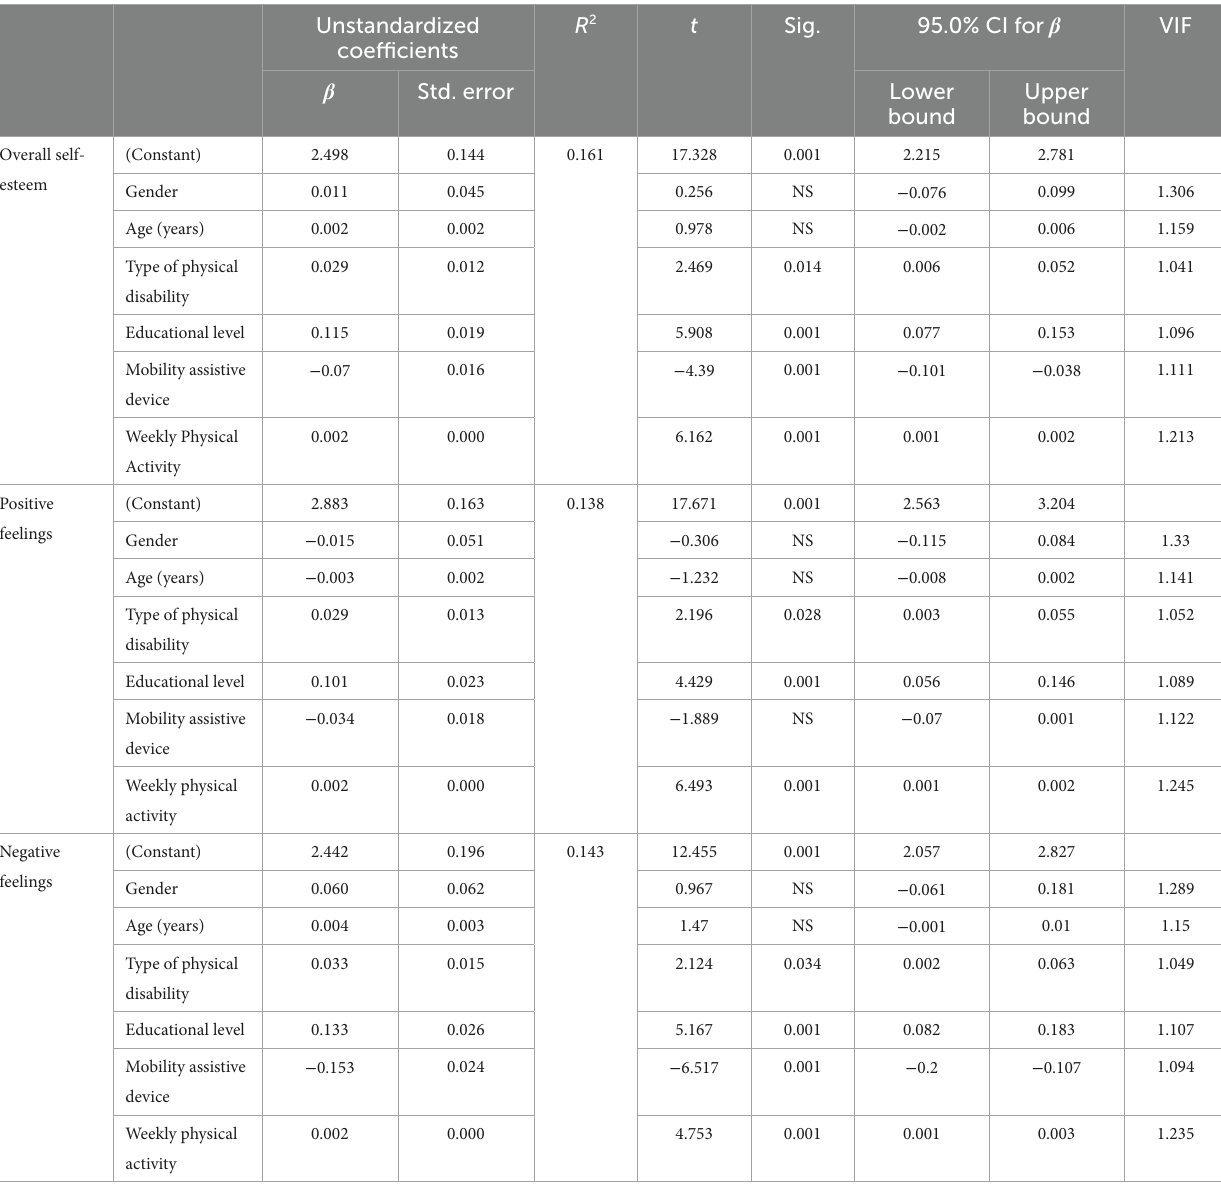
TABLE 2 Weighted least squares regression models for the effect of sociodemographic factors and weekly physical activity on the levels of overall self- esteem and positive and negative feelings among Saudi participants with physical disabilities ( N =